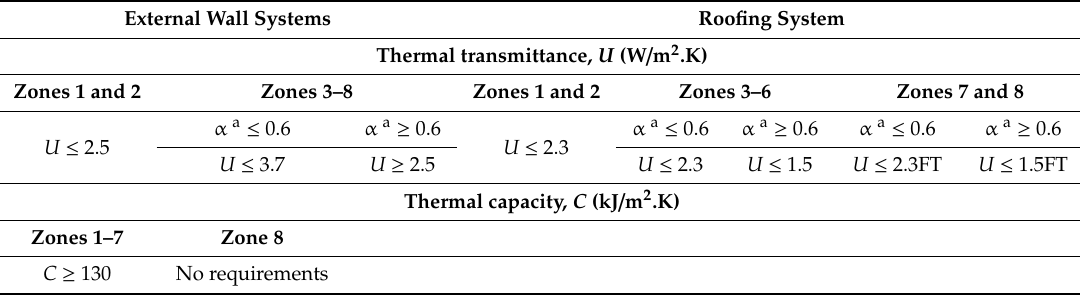
Table 6. Criteria for the simplified procedure.